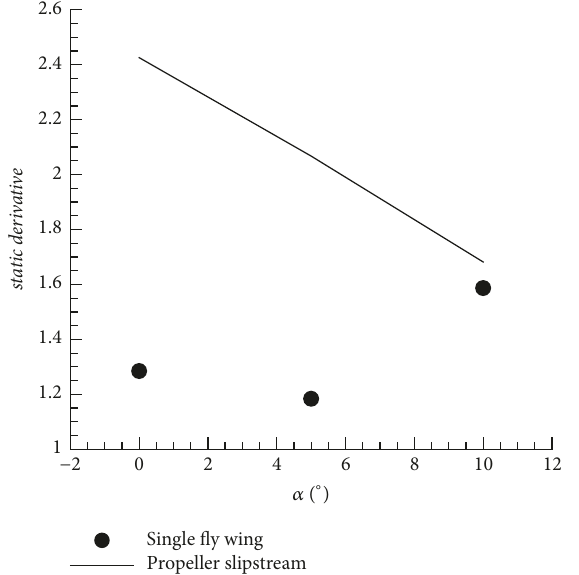
Figure 21: Static derivatives 𝐶 𝑧𝛼 .